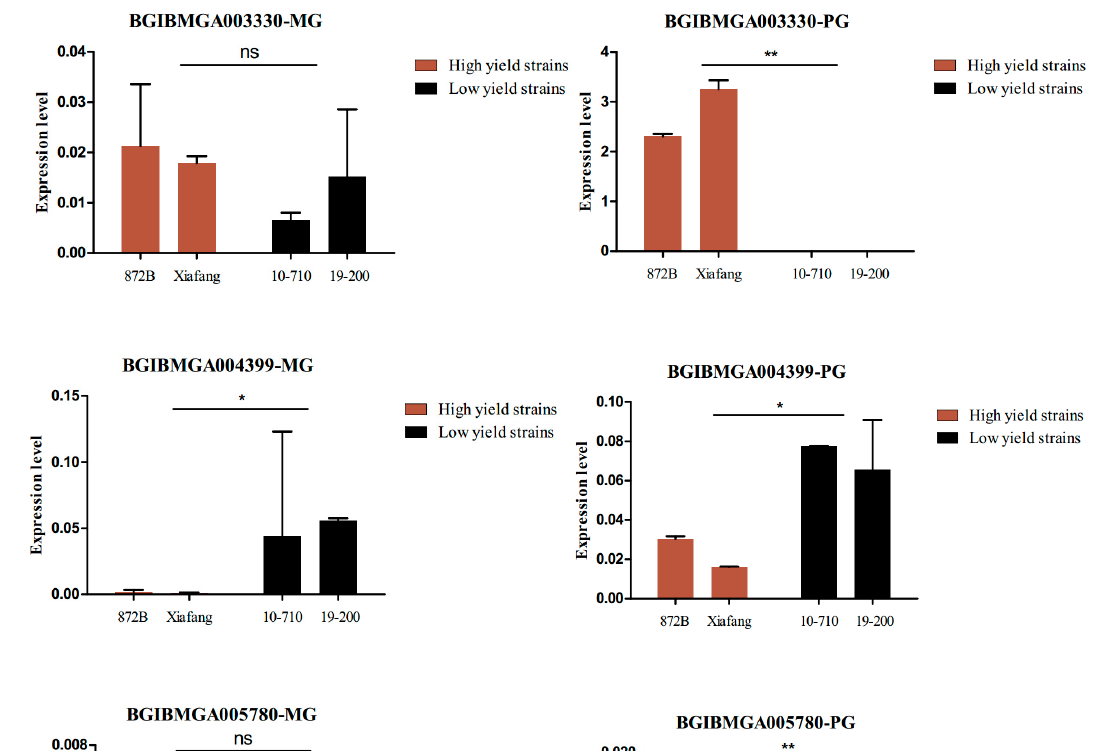
Figure 5. Quantitative verification of common DEGs. MG: Middle silk gland, PG: Posterior silk gland. ns: Not significant; *: p ≤ 0.05; **: p ≤ 0.01.